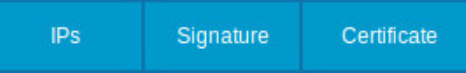
Figure 2. Payload structure of C-to-C protocol.